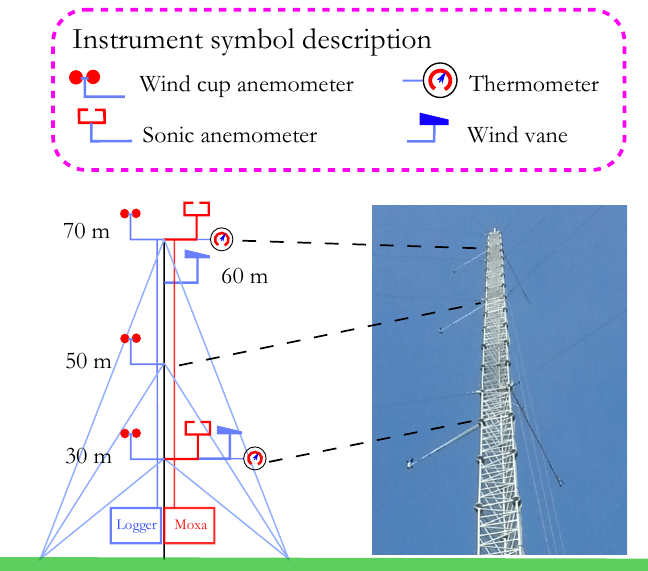
Figure 3. Sketch ( left ) and physical appearance ( right ) of measurement setup for